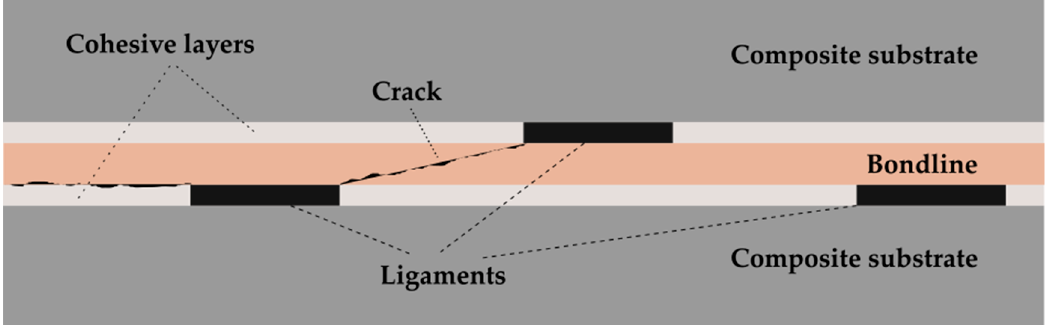
Figure 3. The double interface concept with integrated adhesive ligaments to trigger crack bridg- ing.